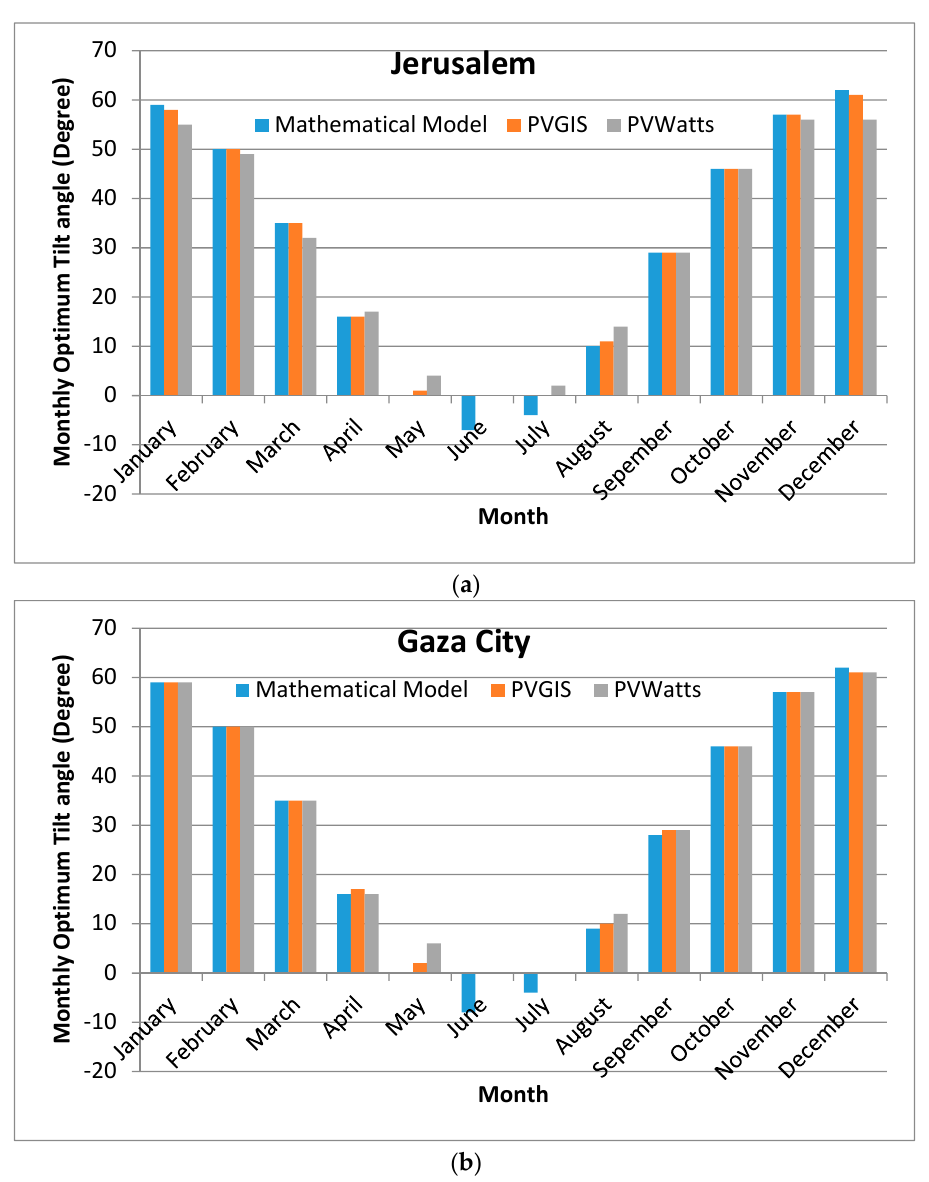
Figure 9. A comparison of monthly optimum tilt angles based on PVWatts and PVGIS with those calculated by the mathematical model: Jerusalem ( a ), Gaza City ( b ).